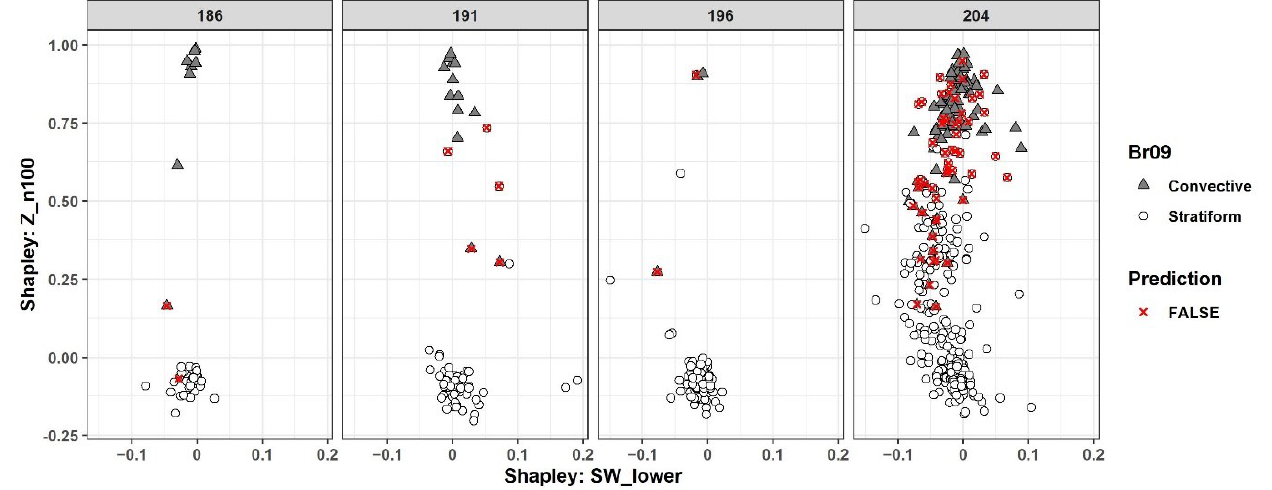
Figure 7. Shapley values of the most important two features for individual minutes across four events.